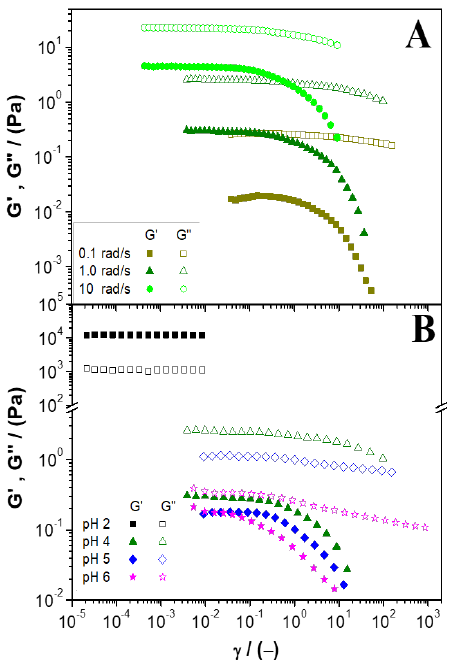
Figure 1. Viscoelastic moduli values as a function of the shear strain applied performed at different frequencies (0.1, 1.0, and 10 rad/s) for the egg yolk (45% in solids) acidified with citric acid at pH 4 ( A ) and values of the viscoelastic moduli at a constant frequency of 1 rad/s as a function of different pH values for the egg yolk (45% in solids) acidified with citric acid ( B ).